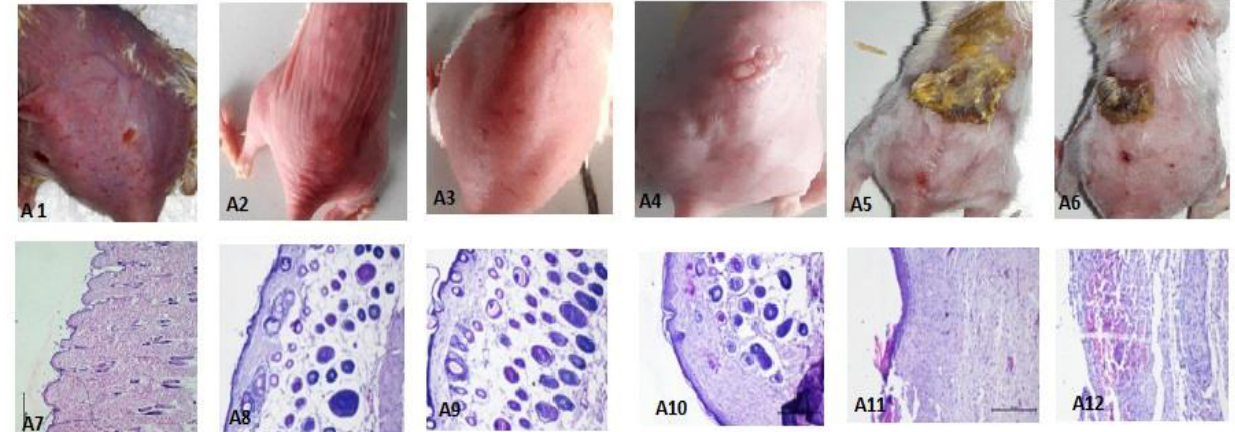
Figure 8. The photographs revealing the appearance of mouse skin ( upper panel) and histopathological sections of mouse skin ( lower panel) from various treatment groups (murine DNCB-induced atopic dermatitis models): positive control ( A1 , A7 ), THC-SLN dispersion ( A2 , A8 ), THC-SLN gel ( A3 , A9 ), Tacroz ® Forte ointment ( A4 , A10 ), free THC gel ( A5 , A11 ) and blank SLN gel ( A6 , A12 ).